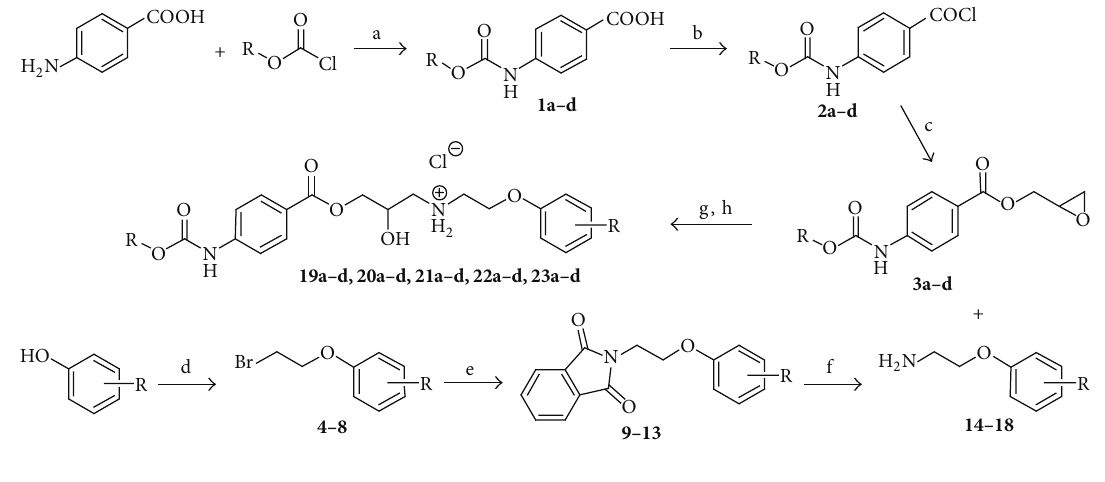
Scheme 1: Synthesis of evaluated compounds. Reagents and conditions: (a) acetone, pyridine; (b) SOCl 2 , toluene; (c) 2,3-epoxypropan-1-ol, THF, and TEA; (d) 1,2-dibromoethane, NaOH; (e) potassium phthalimide, KI, and DMF; (f) NH 2 NH 2 ⋅ H 2 O, ethanol; (g) propan-2-ol; (h) HCl, Et 2 O.